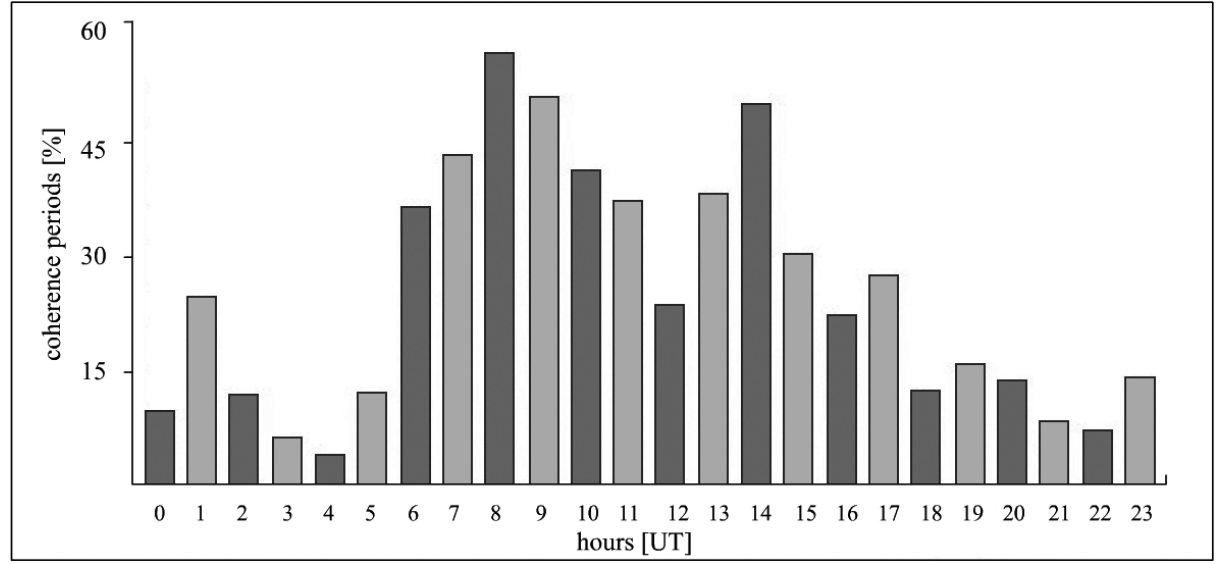
= 5 dBm and T = 10 dBm h'